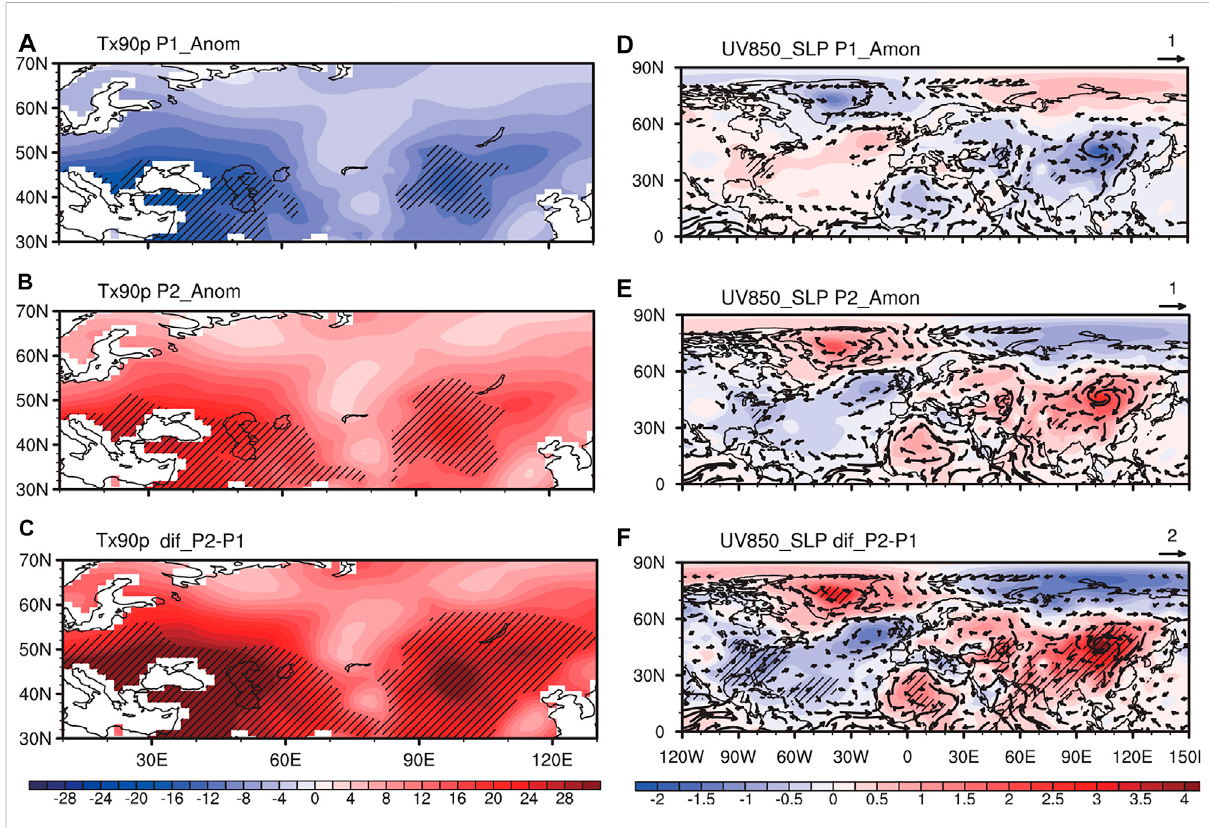
FIGURE 2 Differences in terms of the EHTDs between (A) P1 and the climatology, (B) P2 and the climatology, and (C) P2 and P1 (unit: %); the second column [ (D – F) ] for the sea level pressure (shading, unit: hPa) and wind fi eld at 850 hPa (vector, unit: m/s). Dashed areas indicate signi fi cance at 99% con fi dence level according to the Student ’ s t